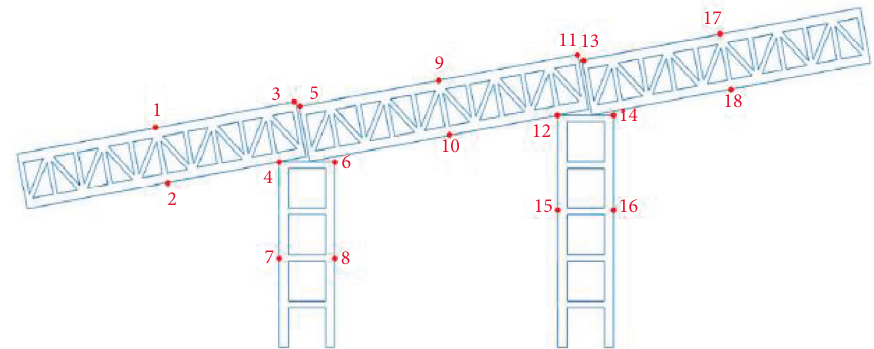
Figure 7: Arrangement of measuring points with vibration